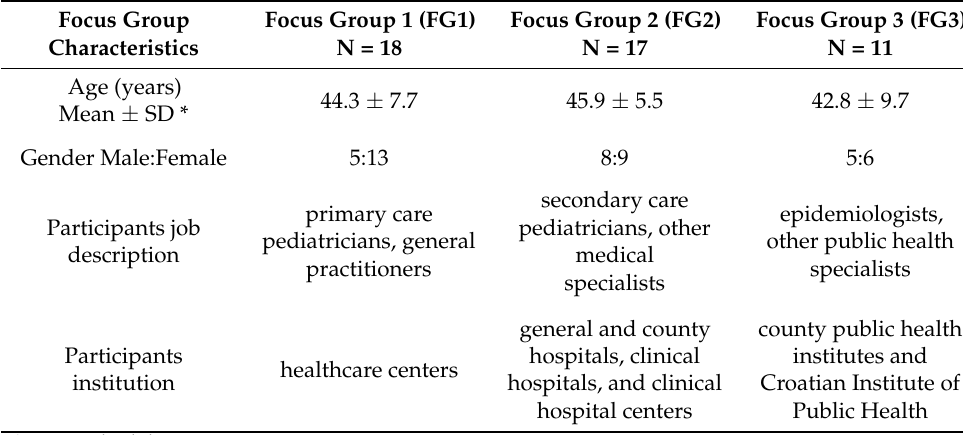
Table 1. The focus group